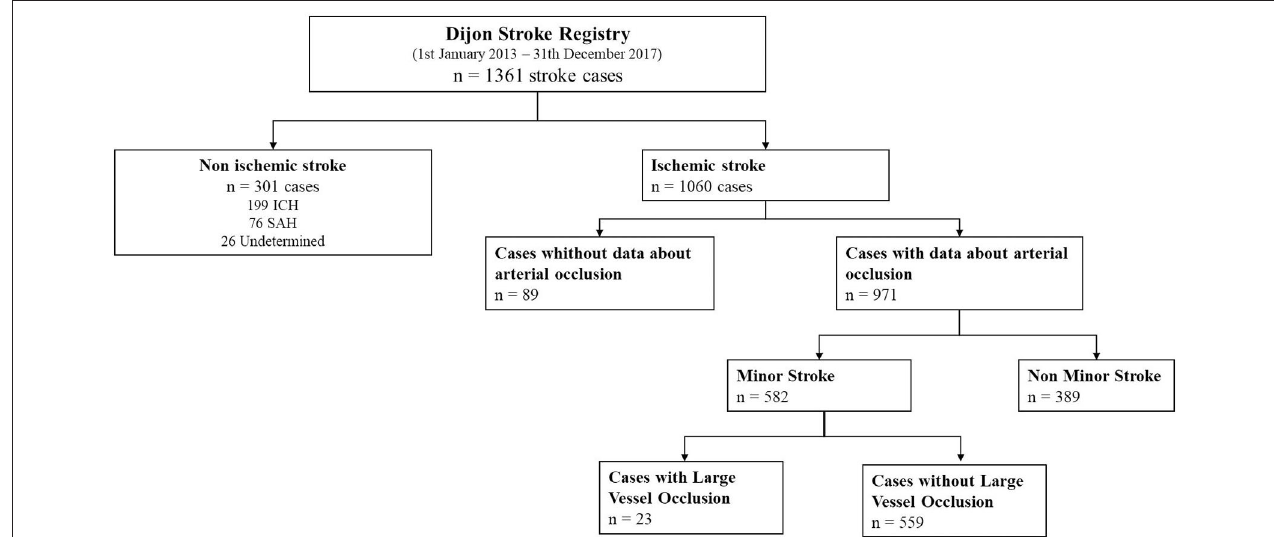
FIGURE 1 | Study flow